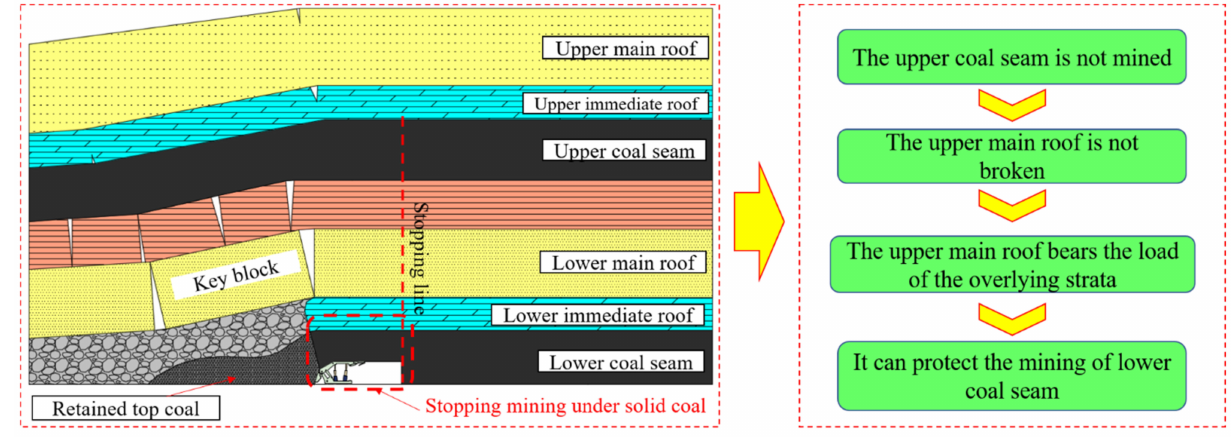
Figure 1. Schematic diagram of stopping mining under solid coal.